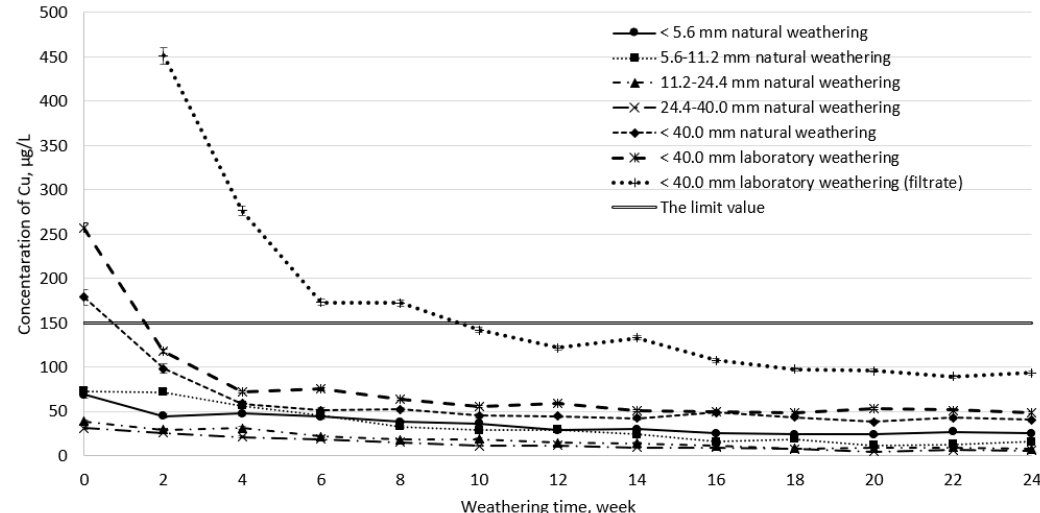
Figure 9. Concentration of copper (Cu) in different fractions of BA eluate and leachate during natural weathering and laboratory aging.